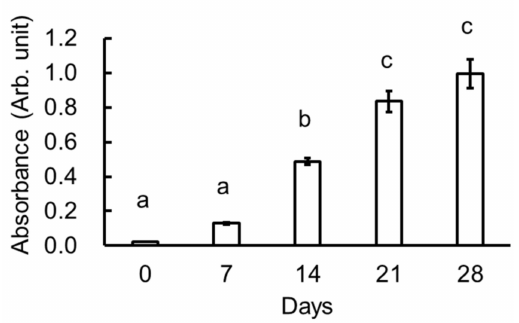
Figure 5. Total melanoidin content in the various garlic samples at 400 nm. Values are mean ± SE (n = 3). Values indicated with di ff erent letters were significantly di ff erent from each other ( p < 0.05).